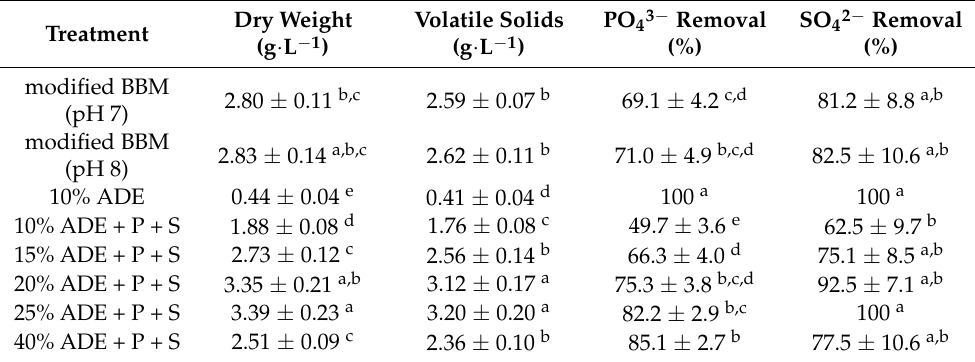
Table 1. C. sorokiniana culture characteristics and nutrient removal from Bold’s Basal Medium (BBM) and diluted anaerobic digester effluent (ADE).